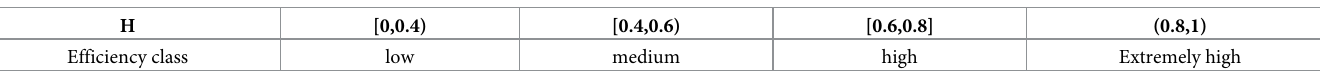
Table 2. Emergency information sharing coordination efficiency level.